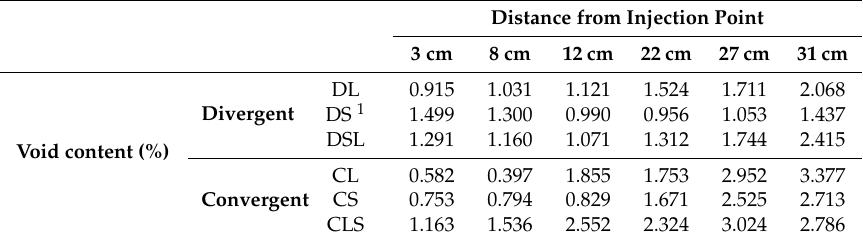
Table 5. Summary of void content analyses.